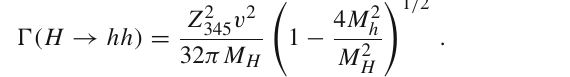
Fig. 7 Contours of the branching fraction BR ( H → hh ) in the exact alignment in the heavy Higgs interpretation, for the first alignment solu- tion (top panels in Fig. 3) in the (μ/ M S , A t / M S ) plane. We exhibit only